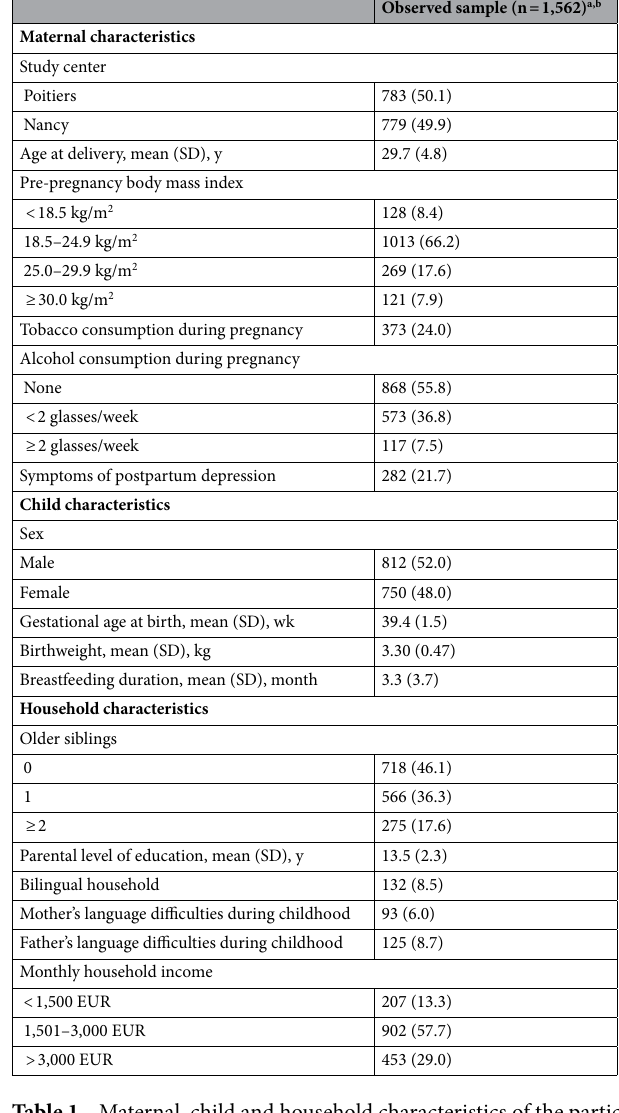
points (cross-sectional analyses). Of note, we observed an inverted U-shaped association between daily screen time and CDI score (age 2 years): the CDI score was 8.7 (95% CI: 3.4, 13.9) points higher on average for children watching screens for 31–60 min than never watching screens; CDI scores were intermediate for children watching screens for > 120 min daily. Although the shape of these associations also seemed nonlinear in cross-sectional analyses at ages 3 and 5–6 years (Table 3) and in the longitudinal analysis (ages 2 to 5–6 years; Fig. 2, Panel A), the associations were not statistically significant. Models with or without mutual adjustment for the two variables of exposure to screens carried out similar estimates (Supplementary Table S3). Higher frequency of TV on during family meals was associated with poorer language scores in all cross- sectional (Table 3) and longitudinal (Fig. 2, Panel B) models. At age 2 years, the CDI score was lower for chil- dren always (vs never) exposed to TV during family meals (mean difference [95% CI]: − 5.9 [− 11.7, − 0.1] CDI points). In cross-sectional analyses at ages 3 and 5–6 years, language composite score and verbal IQ were higher for children never (vs sometimes or more frequently) exposed to TV during family meals (Table 3). In the longitudinal analysis, verbal IQ at age 5–6 years was lower for children always (vs never) exposed to TV during family meals at age 2 years (mean difference [95% CI]: − 3.2 [− 6.0, − 0.3] points). A dose–response relationship was observed for intermediate frequencies of TV during family meals (p for trend = 0.002) (Fig. 2,